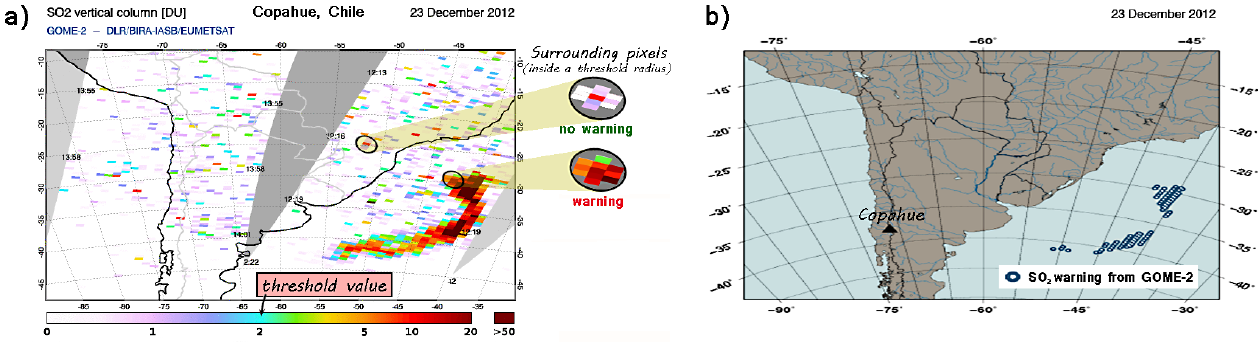
Fig. 7. Eruption of the Copahue Volcano on 23 December 2012. (a) SO 2 vertical column density from GOME-2A. A zoom for two pixels above the “threshold value” is shown with the warnings issued. The black ellipse represents the area defined by the “threshold radius” considered in the SACS warning system (see Table 3). (b) Locations of SO 2 warnings pixels.